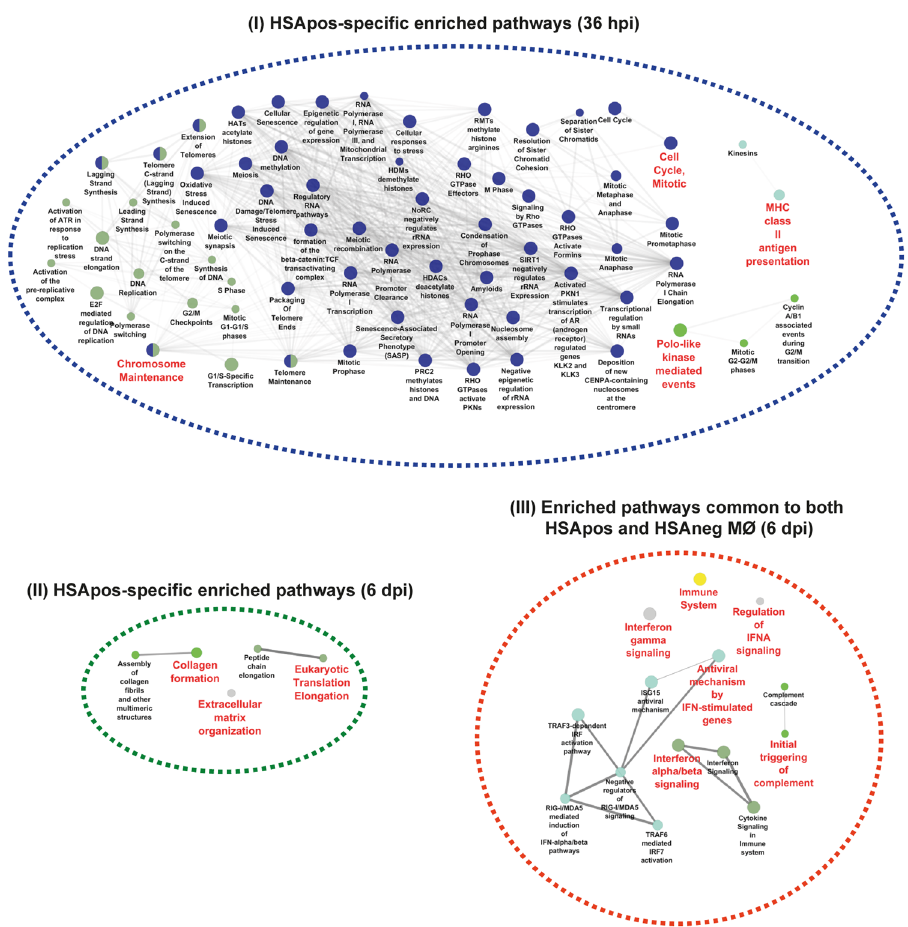
Figure 3. HIV-1 productive infection induces a global remodeling in the MØ transcriptome. Gene ontology analysis of differentially expressed transcripts shows a specific enrichment of DNA-associated pathways in HIV-1-infected MØ at 36 hpi (panel I). An enrichment of ECM- and translation-associated pathways is seen in HSApos MØ at 6 dpi (panel II). IFN-related genes are commonly expressed in HSApos and HSAneg MØ populations at 6 dpi (panel III). The complete list of enriched pathways are displayed in the Supplementary Table